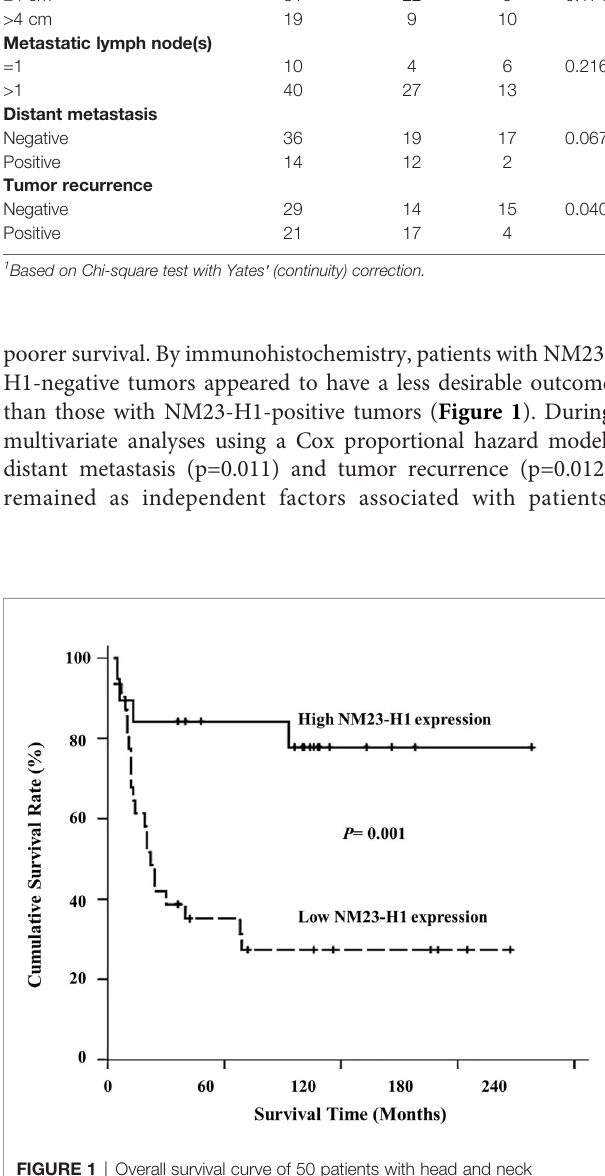
FIGURE 1 | Overall survival curve of 50 patients with head and neck squamous cell carcinoma treated by postoperative radiation associated with NM23-H1 expression of primary tumors. Patients with NM23-H1-positive tumors had signi fi cantly longer survival time than those with NM23-H1- negative tumors (p <